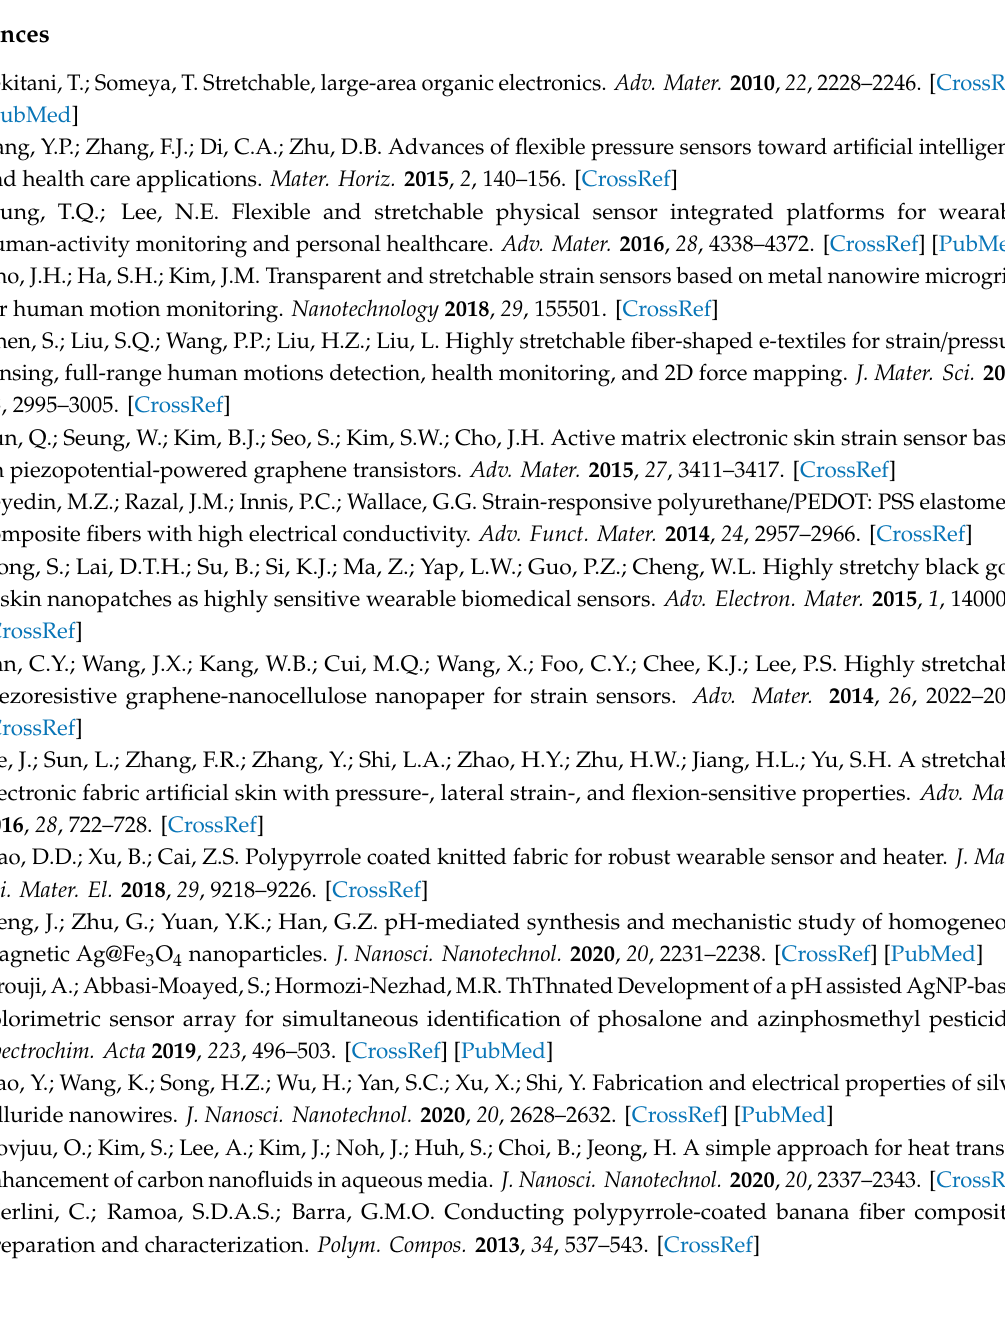
Figure S2: PPy-coated polyester / spandex, nylon / lycra, silk and cotton textiles stretched to the maximum strain. Figure S3: Mass ratios (a) of surface-coated PPy to the textile and resistance ratios (b) of the as-prepared conducting textiles after polymerization with di ff erent volume of Py. Relative resistance change ( ∆ R / R 0 ) of the as-prepared textiles prepared with 50 µ L Py (c), 100 µ L Py (d), 150 µ L Py (e) and 200 µ L Py (f). Figure S4: Current responses of a textile-based sensor upon periodic stretching-releasing cycles under a strain of